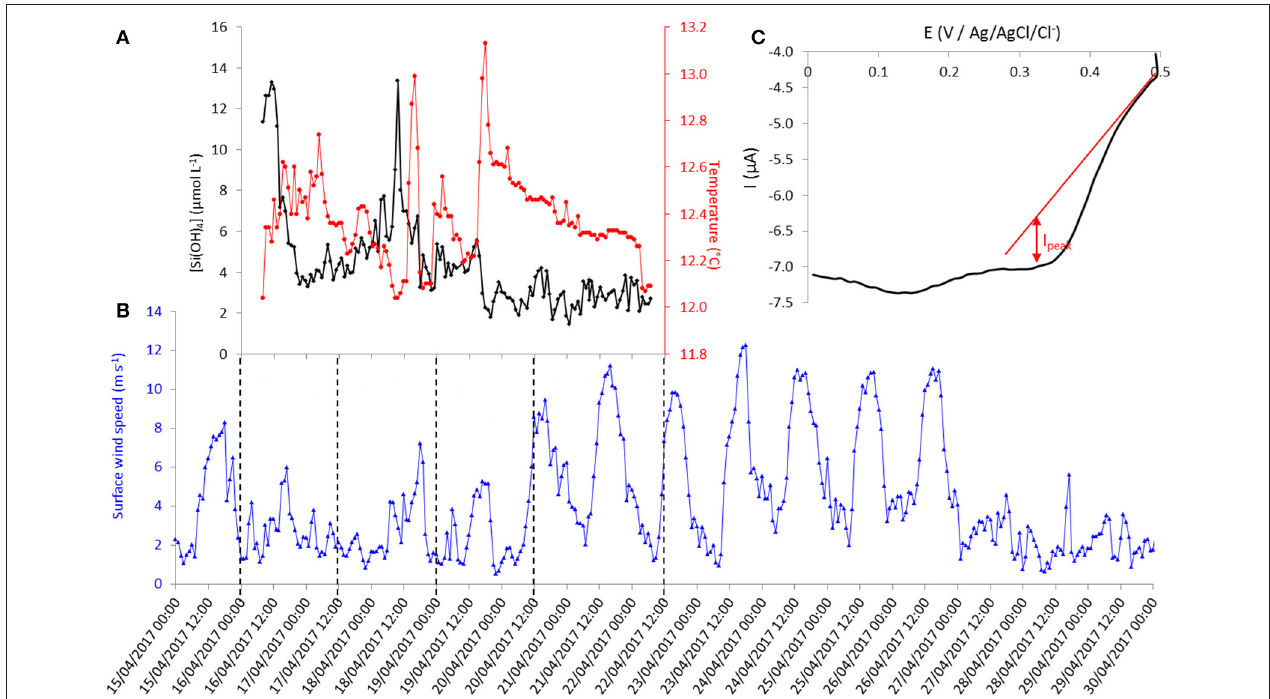
FIGURE 7 | (A) Time evolution of silicate concentration and temperature recorded by the sensor at 55 meters depth at Talcaruca point between the 16th and the 22nd of April 2017 (local time: UTC-4 hours). (B) Time evolution of hourly mean value of surface wind speed from Punta Lengua de Vaca meteorological station. (C) Cyclic voltammogram (forward cycle) at 100mV s − 1 on gold working electrode (Ø = 2mm).